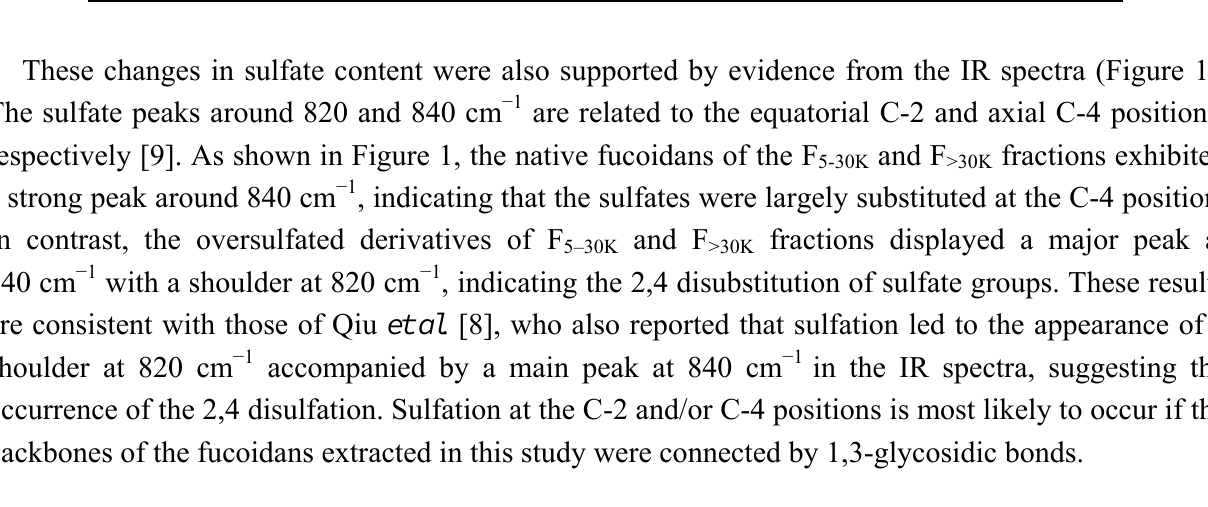
Figure 1. FT-IR spectrums of (a) native and (b) oversulfated fucoidans. The fucoidans were scanned between 500 and 1,200 cm − 1